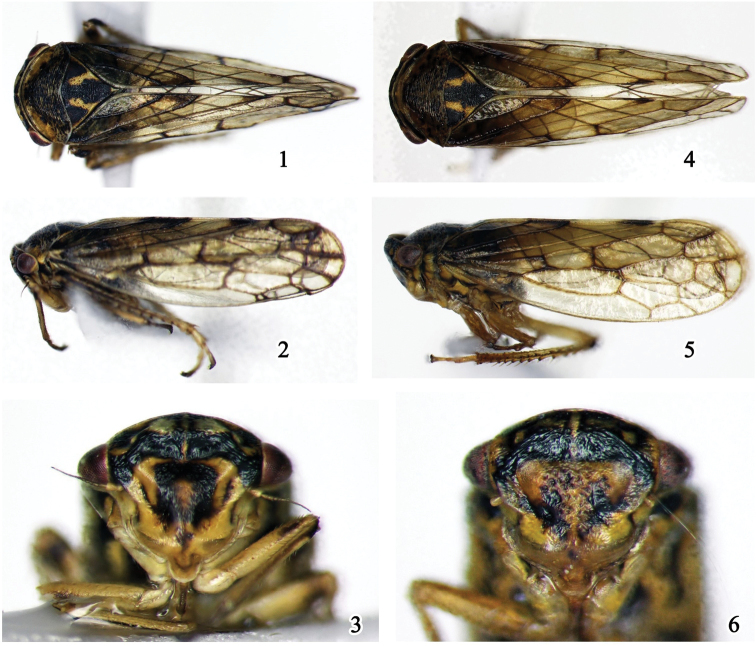
Males of Oncopsis in dorsal (1, 4), and lateral (2, 5) views, and face (3, 6) 1–3O.konkaensis sp. nov. 4–6Oncopsismoxiensis sp. nov.